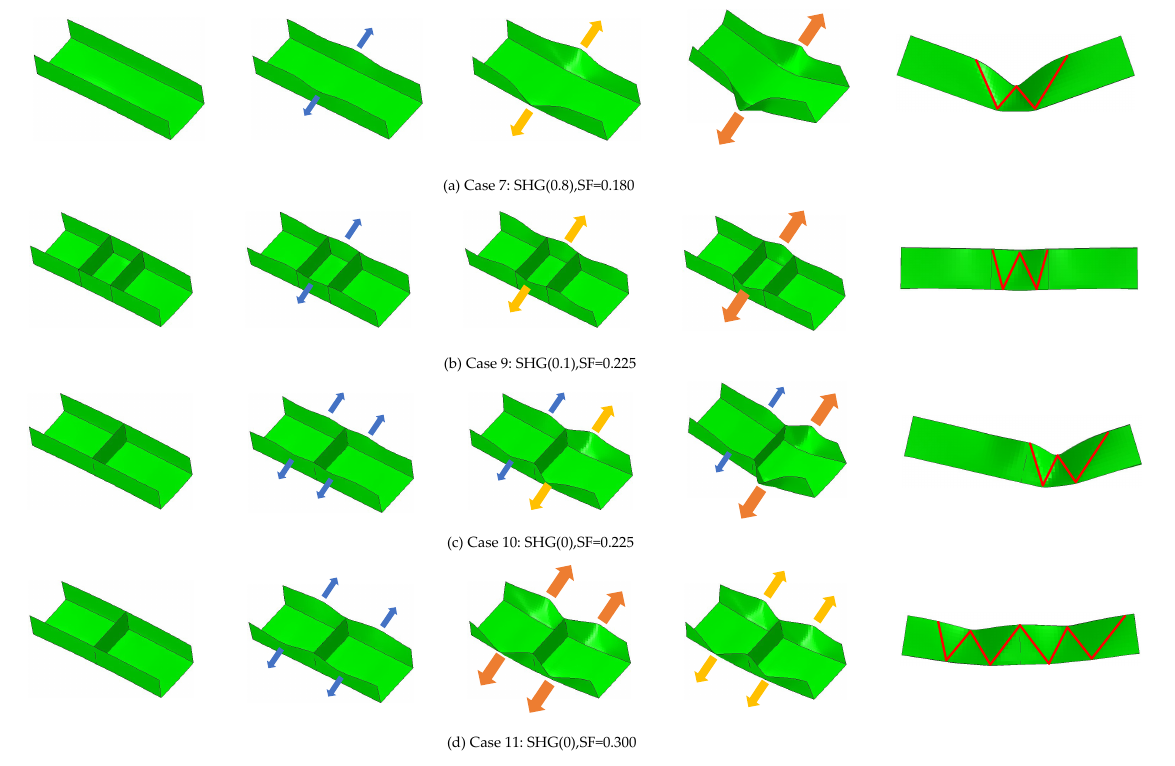
Figure 11. Local creases evolution process: ( a ) 5 ms, ( b ) 13 ms, ( c ) 30 ms, ( d ) 52